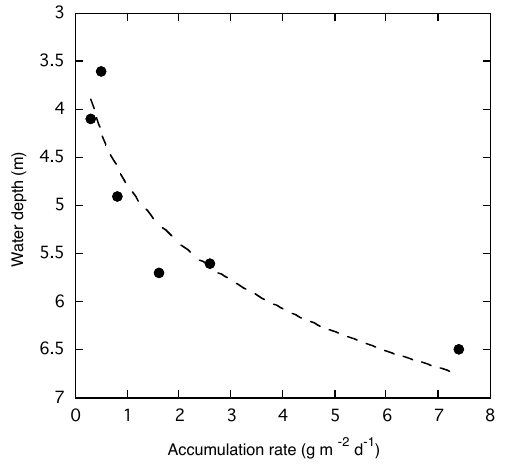
Fig. 4: Mass accumulation rates as a function of water depth of individual traps 3 Fig. 4. Mass accumulation rates as a function of water depth of in- dividual traps calculated for the period 15 to 29 May 2007. Dashed calculated for the period 15 to 29 May 2007. Dashed line represents best fit for visual 4 line represents best fit for visual guide. 5